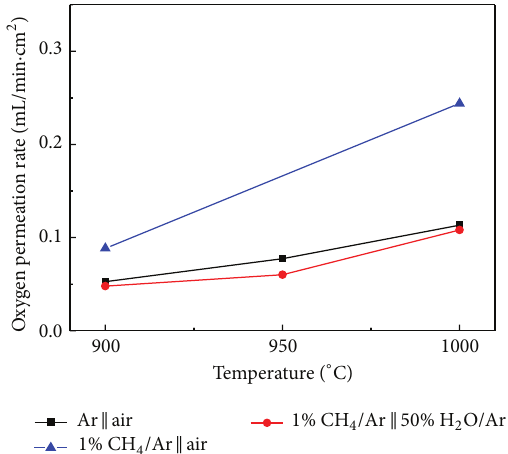
Figure 5: The oxygen permeability of the microtubular LSTF membrane as a function of temperature.